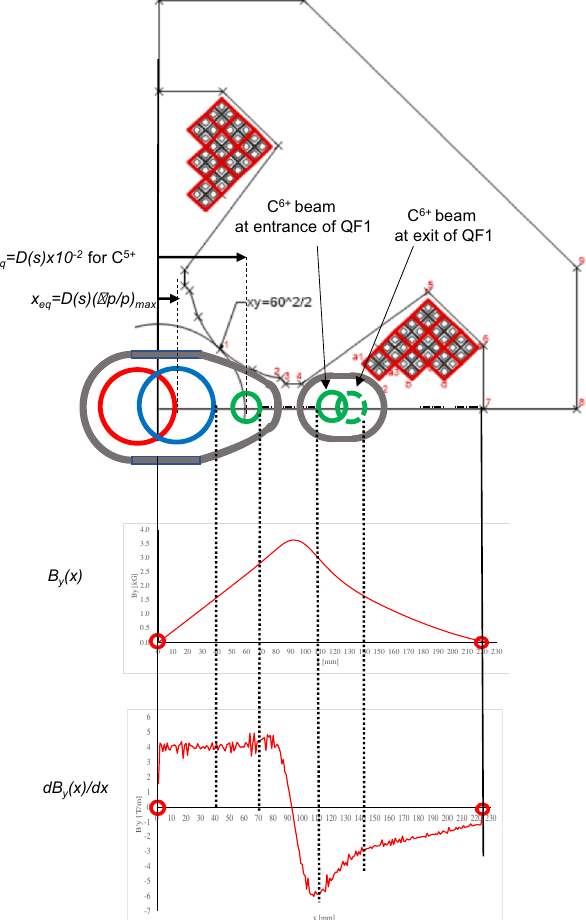
FIG. 14. Specific focusing quadrupole magnet QF1 with ceramic chambers (gray) and field distributions. Blue and red circles mean outer edges of the injected beam with a momentum spread of j Δ p=p j ¼ 0 . 1